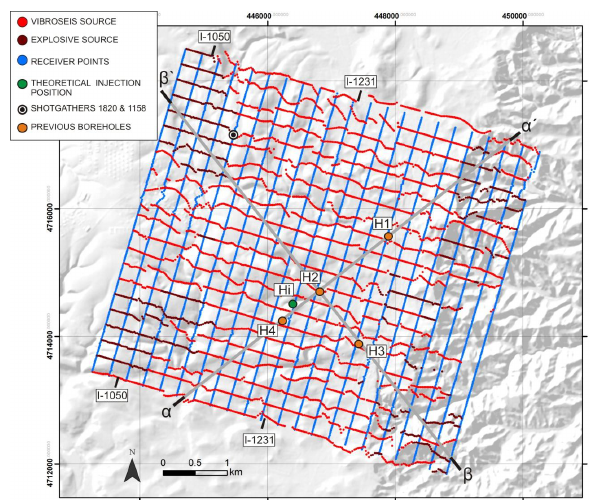
FIG. 2: Map with the position of the elements of the 3D seismic reflection experiment acquired in Hontomín. Light red points mark the position of Vibroseis source shot points. Deep red points mark the position of the explosive source shot points. Blue points mark the receiver positions. The green circle marks the proposed position for the CO 2 injection borehole. The orange circles mark the position of previous boreholes (drilled for oil exploration).